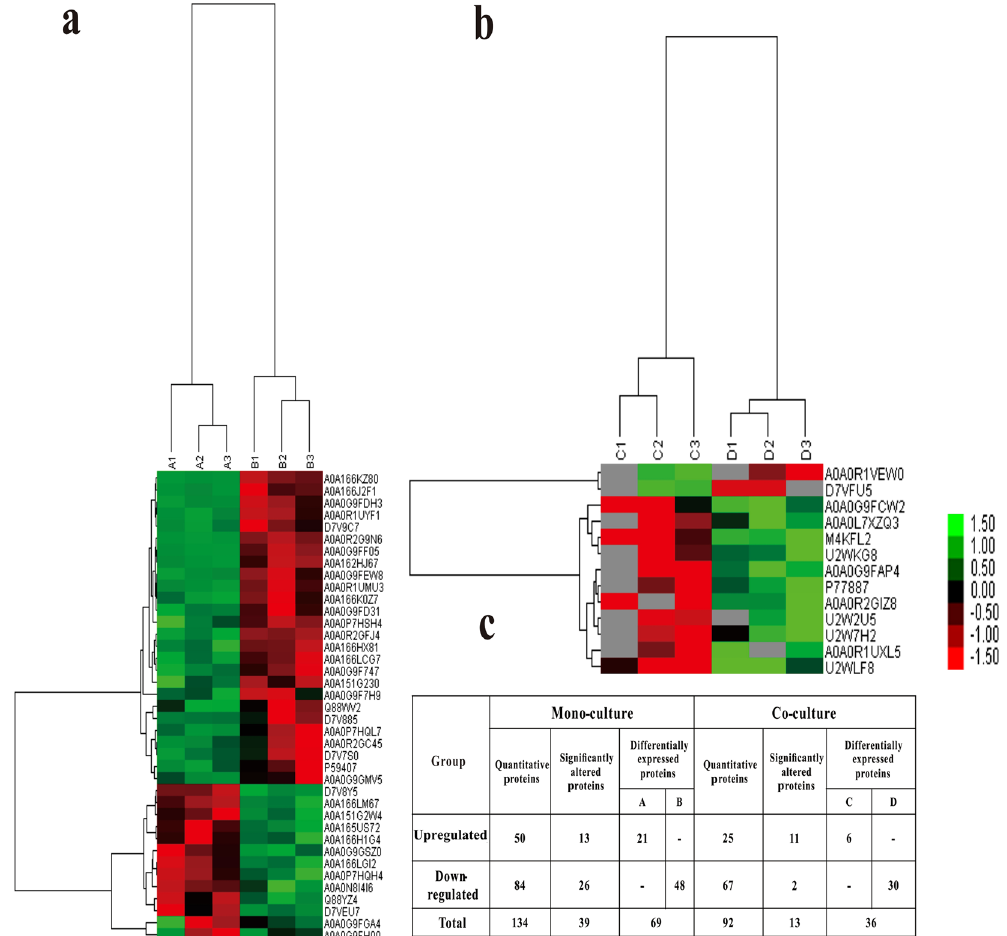
Figure 4. Heatmap of obviously altered proteins in mono-cultivation ( a ) and co-cultivation ( b ). A1, A2, A3- L. plantarum KLDS1.0391 luxS mutant strain; B1, B2, B3- L. plantarum KLDS1.0391 wild-type strain; C1, C2, C3- KLDS1.0391 luxS mutant strain co-cultivated with L. helveticus KLDS1.9207; D1, D2, D3- KLDS1.0391 wild-type strain co-cultivated with L. helveticus KLDS1.9207. Up- and downregulated proteins are indicated in shades of green (increased) and red (decreased), respectively. ( c ) Number of differential proteins. ‘ − ’ indicates that protein expression was lower than the detection limit of